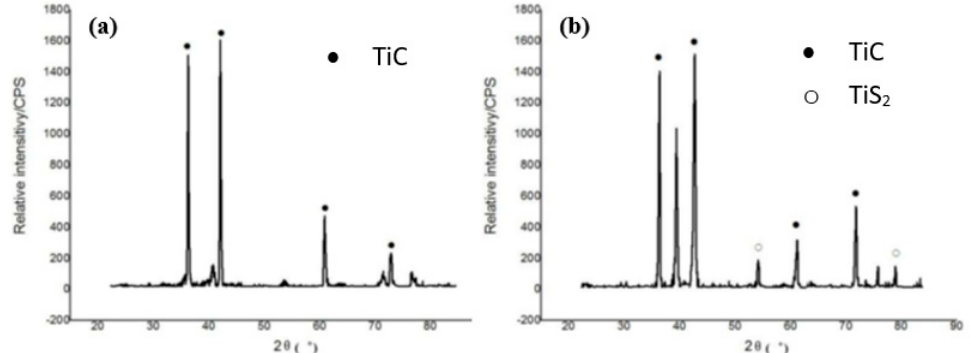
Figure 15. XRD patterns when EDM was conducted on Ti-6Al-4V alloy: ( a ) using Cu electrode at current = 1.5 A, pulse on-time= 15 µ s, and pulse off-time = 15 µ s; ( b ) using Cu-SiC electrode at cur- rent = 1.5 A, pulse on-time = 15 µs, and pulse off-time = 15 µs [68]. (With kind permission from Elsevier).